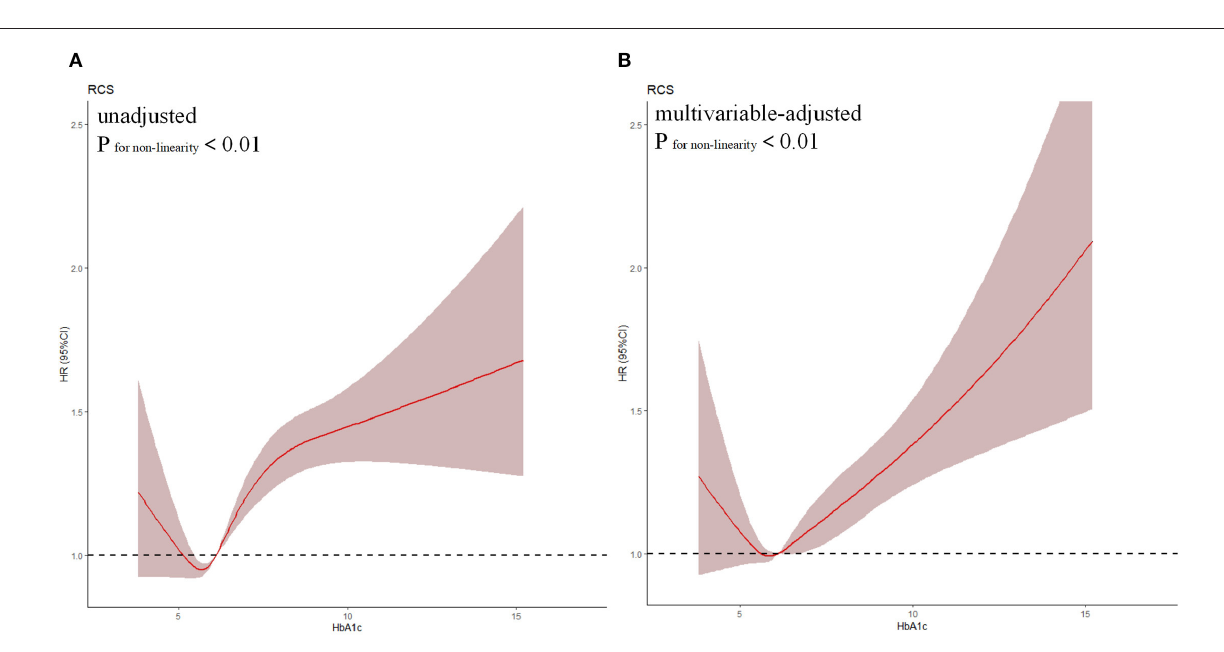
In subgroup analysis, the U-shaped association between levels of HbA1c and long-term mortality in CAD patients is stable in most subgroups. However, the U-shape association was strong in male subgroup while slightly reduced in female